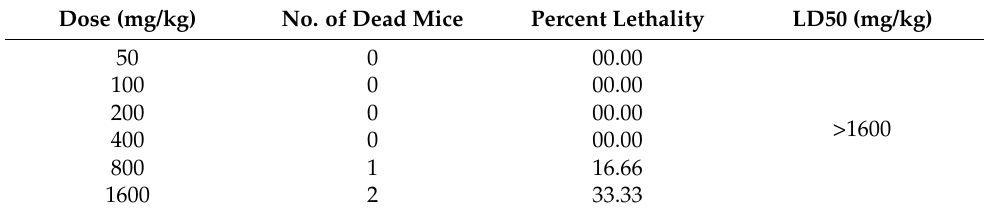
Table 7. In vivo acute toxicity test of norfloxacin nanoparticles. Dose (mg/kg) No. of Dead Mice Percent